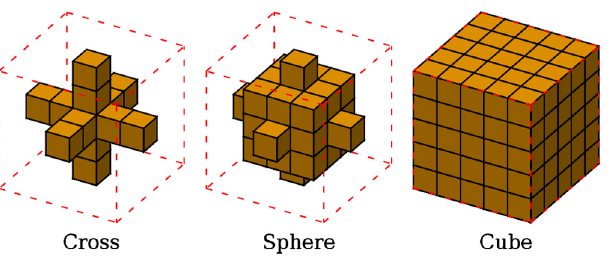
Figure 2. Kernels of the Savitzky–Golay filter with different shapes for n = 2, where n indicates the number of voxels placed along the Cartesian directions on each of the six sides of the central voxel. The dashed red lines depict the cubes bounding the